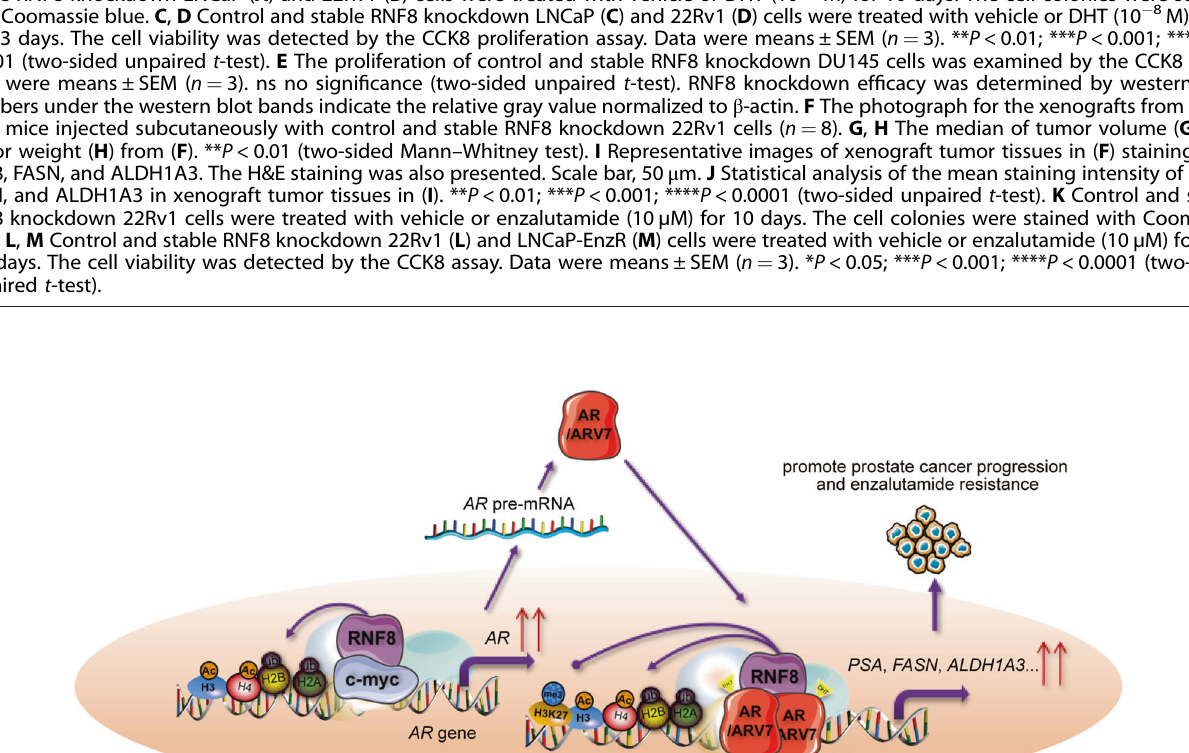
Fig. 8 Schematic representation of RNF8 upregulating AR/ARV7 action. RNF8 forms a complex with c-Myc being recruited together to the c-Myc binding site in the AR gene, inducing the ubiquitination of H2A/H2B and acetylation of H3/H4. This effect causes increased transcription of the AR pre-mRNA, resulting in enhanced AR/ARV7 expression. RNF8 interacts with AR/ARV7 binding onto the ARE of AR target gene, promoting H2A/H2B ubiquitination and H3/H4 acetylation while attenuating H3K27 tri-methylation around this region. This effect ultimately leads to increased expression of AR target genes, which may accelerate advanced PC progression and enzalutamide